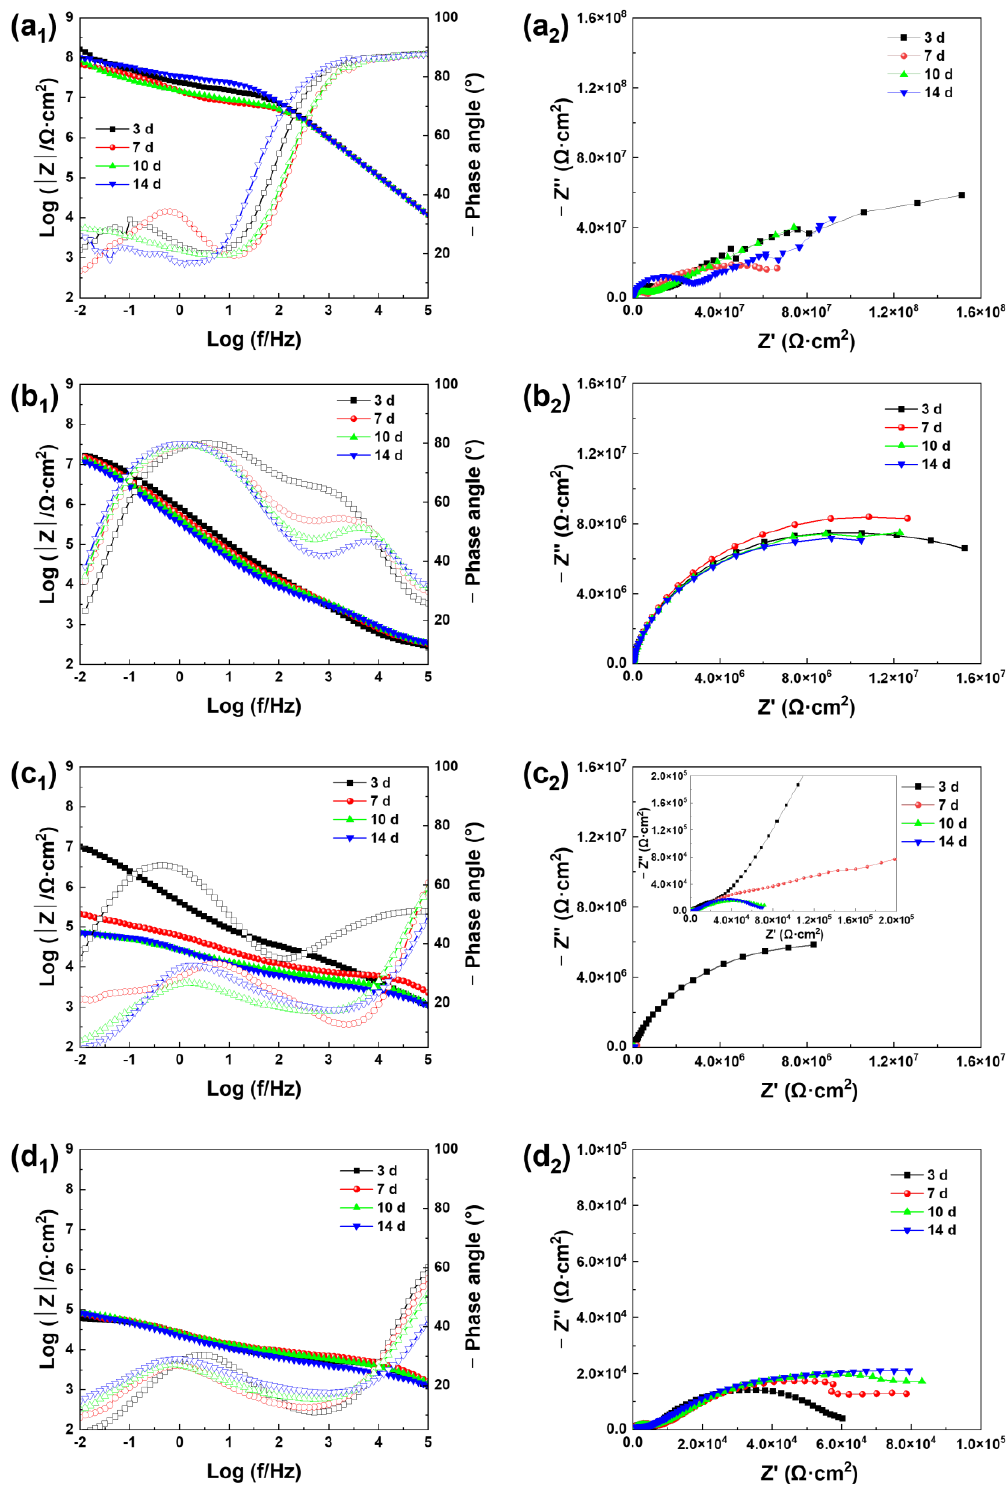
Figure 4. Nyquist and Bode plots of the samples from ( a 1 , a 2 ) the sterile medium; ( b 1 , b 2 ) the P. aeru- ginosa − inoculated medium with 100% nutrients; ( c 1 , c 2 ) the P. aeruginosa − inoculated medium with 10% nutrients, and the inset is the Nyquist plot in the high frequency region; ( d 1 , d 2 ) the P. aeru- ginosa − inoculated medium without nutrients after 3, 7, 10, and 14 days of immersion.